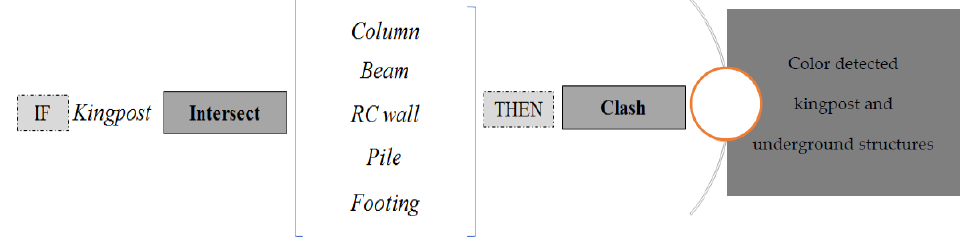
Figure 7. The IF-THEN condition statement of clash detection between kingpost and underground structures.